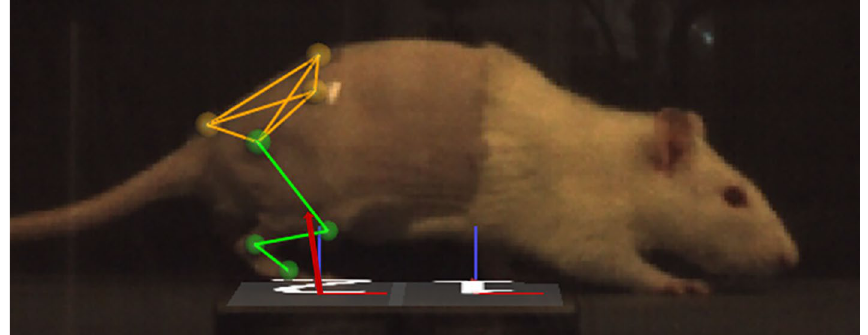
Figure 1. Vicon Nexus 2.7.1 3-D overlay of motion capture marker placements. 3 mm markers were applied to the lateral knee, ankle, and fifth metatarsal (TOE) of the female Lewis rats. 5 mm markers were applied to the spine, hip, right anterior superior iliac crest (RASI), and the tail. Motion capture data was collected at 200 Hz and ground reaction force (GRF) data was collected at 1000 Hz. Data was reconstructed using Vicon Nexus 2.7.1 resulting in overlays of joint positions and GRF vector projections as shown